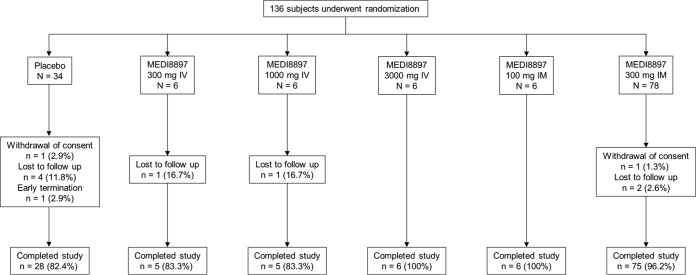
Subject disposition.